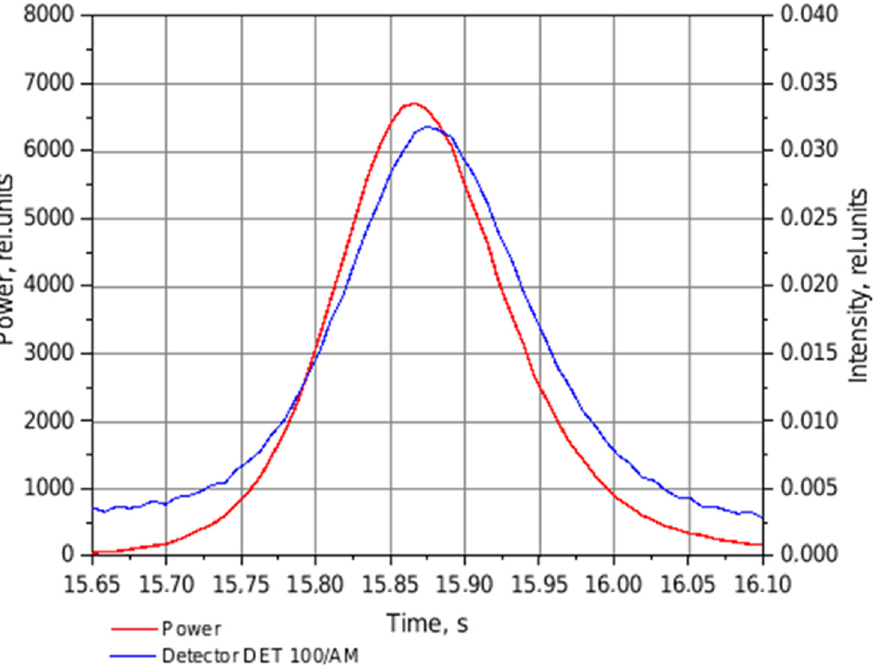
Figure 6. Time dependence of reactor power and signal from Si–photodiode DET100A. Argon is at a pressure of 305 Torr, and lithium layer temperature before reactor startup is 710 K.